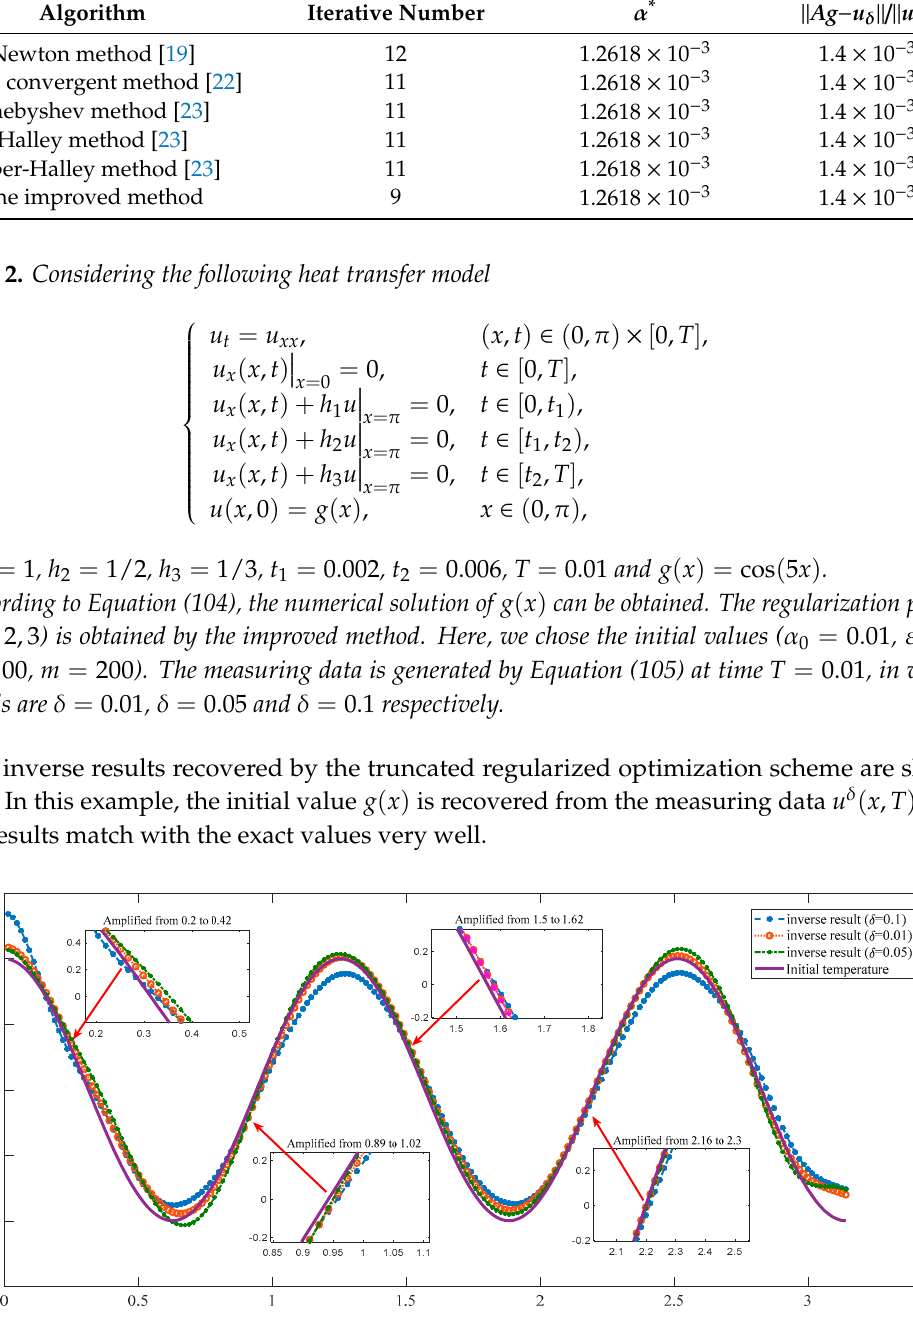
Table 2. The comparison of the improved method with other methods (